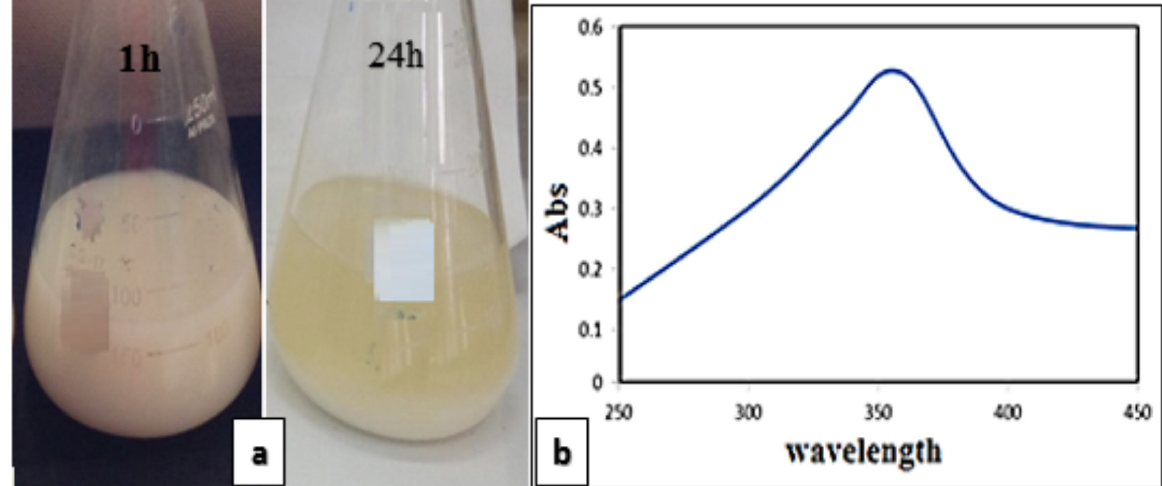
solution after 1 h and 24 h. ( b ) UV-Vis. 2